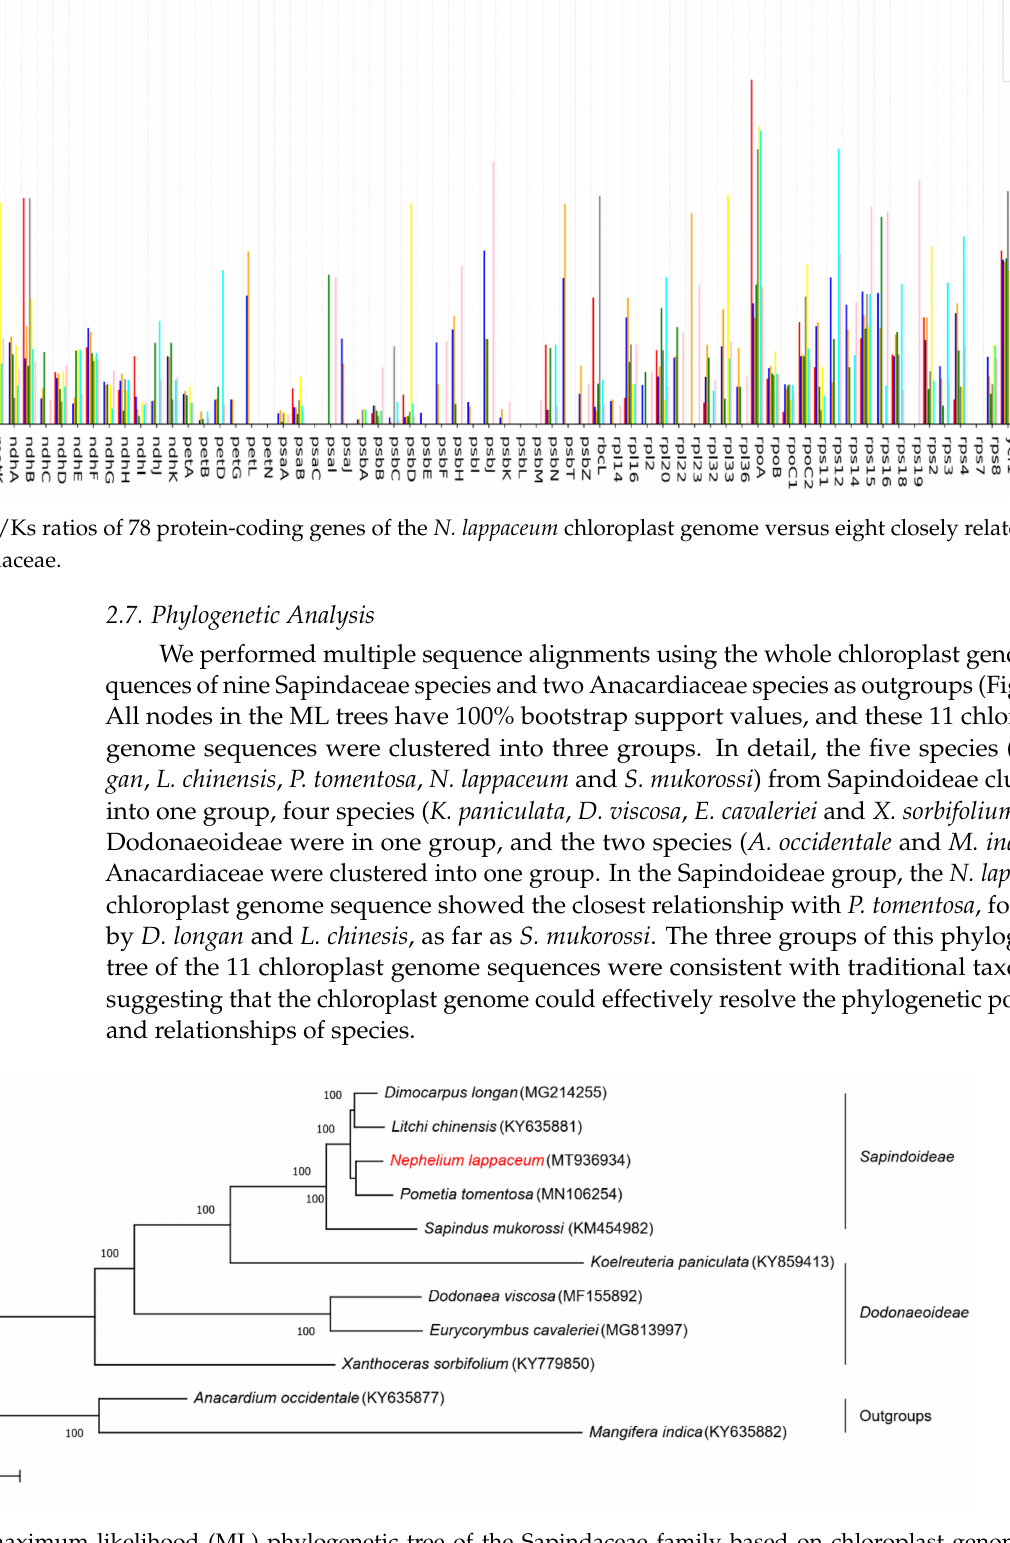
Figure 7. The maximum likelihood (ML) phylogenetic tree of the Sapindaceae family based on chloroplast genome sequences. The numbers in each node were tested by bootstrap analysis with 1000 replicates. Anacardium occidentale and Mangifera indica were set as the outgroups. The position of N. lappaceum is indicated in red